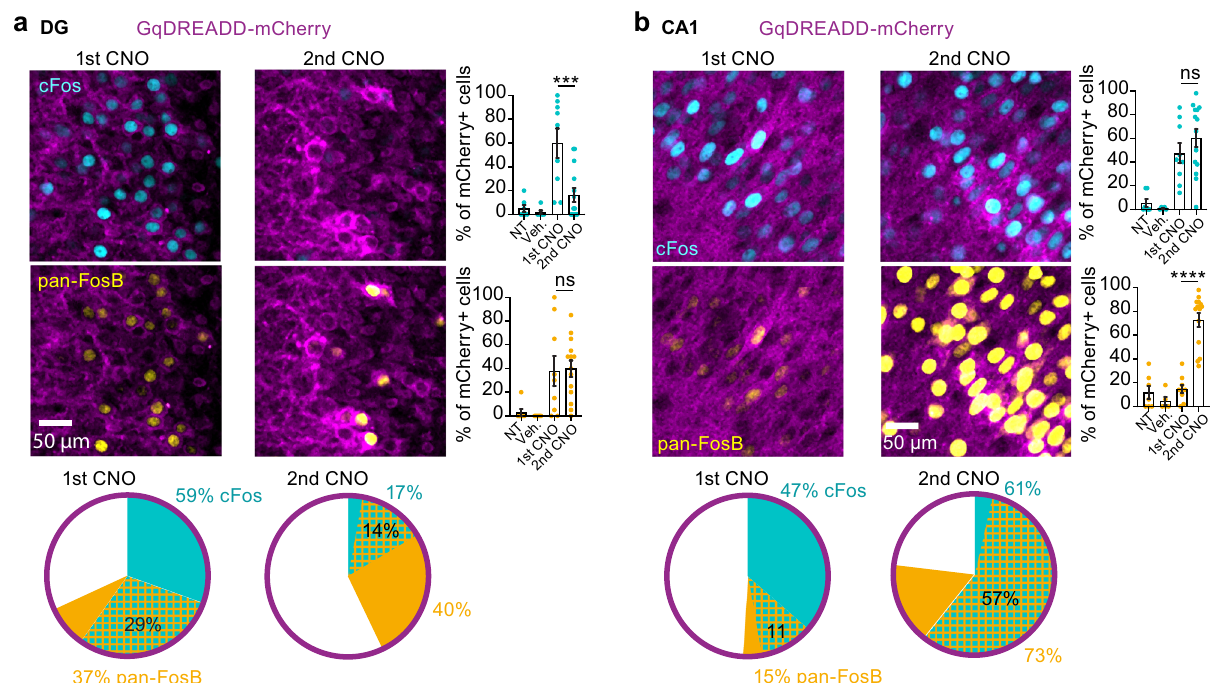
Fig. 7 | Repeated chemogenetic induction of cFos expression in slice culture. a AAV transduction of hippocampal slice culture with CaMKaII- hM3Dq-mCherry (magenta). Application of CNO activates DREADD and induces strong cFos (cyan) expression in DG (1st CNO, n =9 slices). A second application 24h later triggered signi fi cantly less cFos expression (*** p =0.0003, 2nd CNO, n =14 slices, one-way- ANOVA with Š ídák ’ s multiple comparisons test). No cFos was detected in cultures inhibit the expression of cFos in these neurons 26,44 . We quanti fi ed the